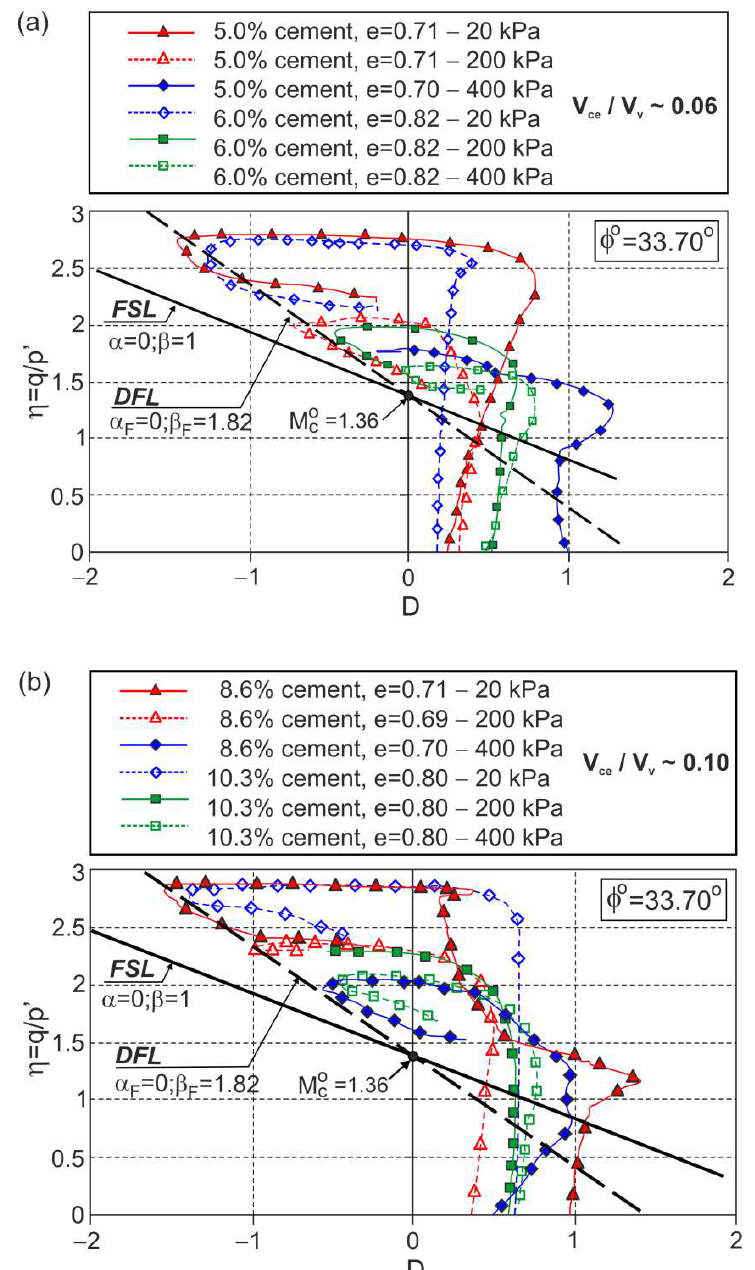
Figure 7. Stress ratio–dilatancy relationships for the drained triaxial compression of fine sand with different cement–void ratios: ( a ) V ce /V v ≈ 0.06; ( b ) V ce /V v ≈ 0.10 (adapted from [27]). Used with permission of the American Society of Civil Engineers, ASCE, from Influence of Cement–Voids Ratio on Stress-Dilatancy Behaviour of Artificially Cemented Sand., Consoli, N. C.; Cruz, R. C.; Viana da Fonseca, A.; Coop, M. R., J. Geotech. Geoenviron. Eng. 138 (1), 2012, [doi:10.1061/(ASCE)GT.1943-5606.0000565]; permission conveyed through Copyright Clearance Center, Inc. For all the tests, three stages of plastic flow are visible. The characteristic points ( @ #∗ , @ ’∗ , F*, F, and E) are not shown in Figure 7 for clarity. The dilatant failure states can be easily identified, and the approximate DFL can be drawn in the (cid:1) − (cid:3) plane. The DFLs for both cement - void ratios H and H are defined by Equation (1) (cid:14)6 H I ≈ 0.06⁄ (cid:14)6 H I ⁄ ≈ 0.10 with (cid:13) , and (cid:17) (Figure 7). (cid:15) = 1.36 ( (cid:27) (cid:15) = 33.7° ), (cid:16) (cid:14) E = 0 E = 1.82